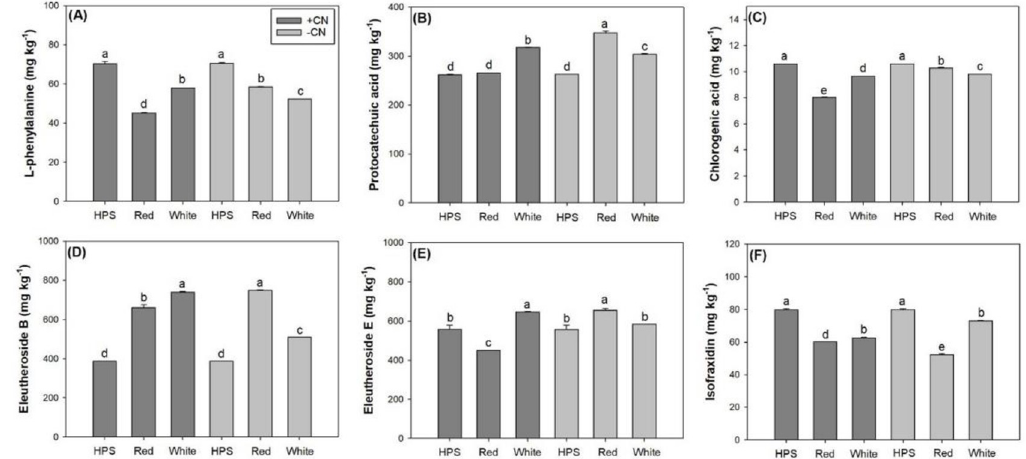
Fig 7. Contents of L-phenylalanine (A), protocatechuic acid (B), chlorogenic acid (C), eleutheroside-B (D), eleutheroside-E (E), and isofraxidin (F) in stems of Eleutherococcus senticosus seedlings subjected to combined spectra and chitosan nanoparticle addition (CN) treatments. + CN, with CN addition; -CN, without CN addition; HPS, high-pressure sodium spectrum; Red, red- light light-emitting diode (LED) spectrum; White, white-light LED spectrum. Error bars present standard errors and different letters are given over means with differences identified by Turkey test ( α <